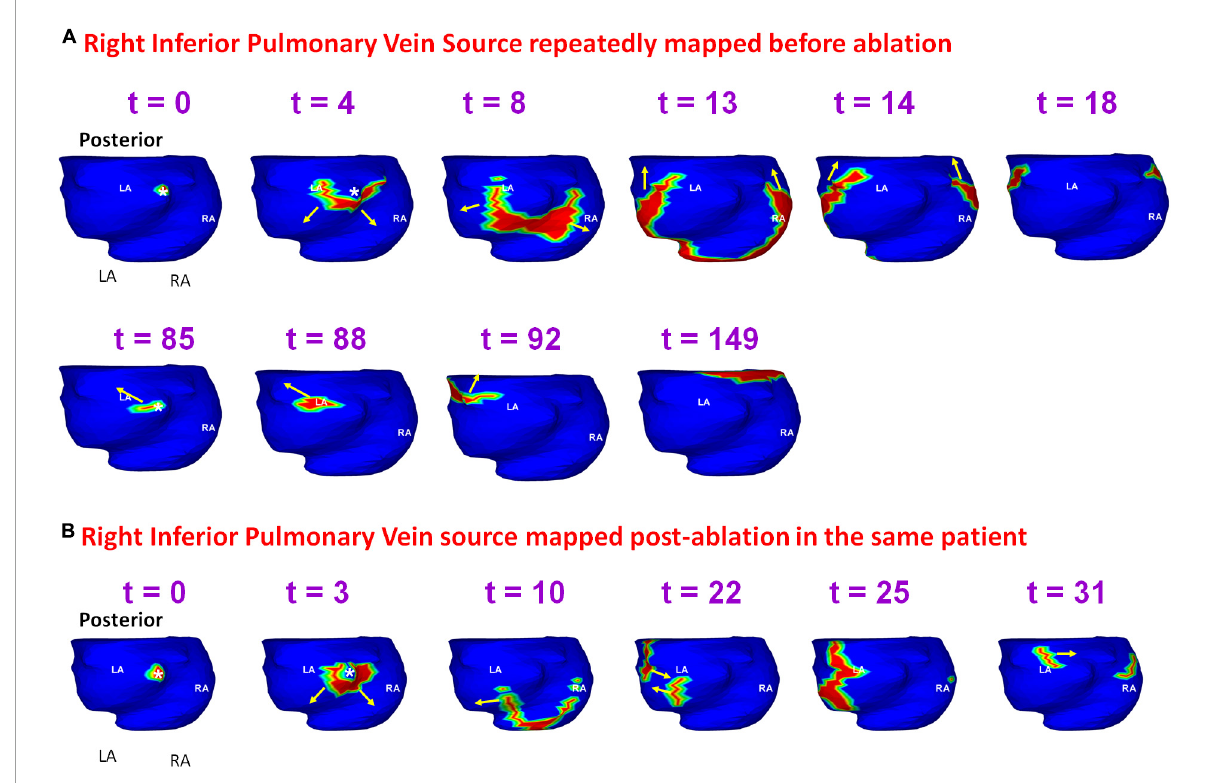
FIGURE12 Persistence of pre-ablation RIPV source during recurrent AF. Panel (A) shows the activation originating at the RIPV ( t = 0, t = 85 ms) within the same mapping interval during pre-ablation AF. The RIPV source was mapped again during recurrent AF as shown in panel (B) . RIPV – right interior pulmonary vein. Supplementary Video 8 shows the activation during pre-ablation and recurrent